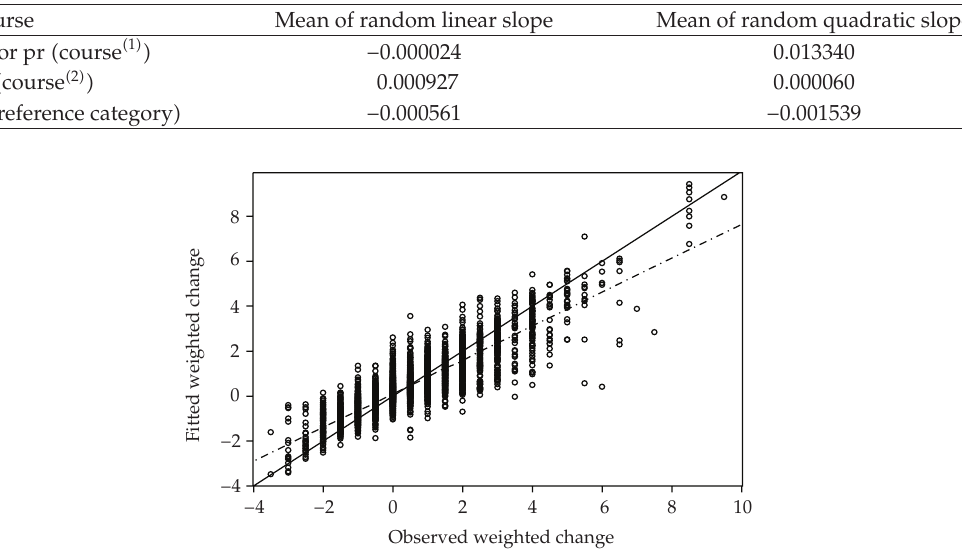
Table 9: Mean of random slope estimates, stratisfied for courses.